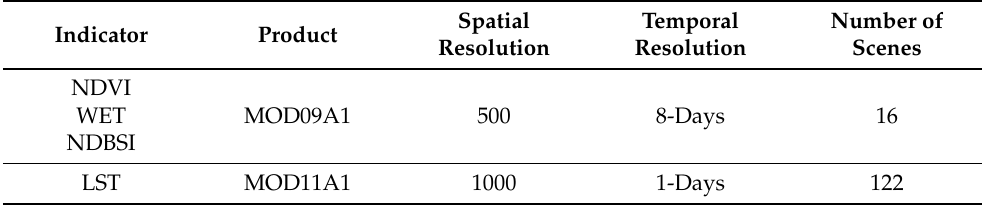
Table 1. GEE data